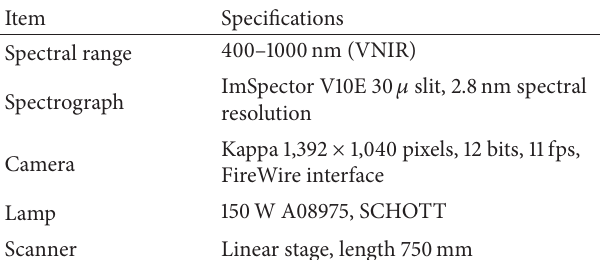
Figure 1: Overall inspection flow of the proposed system. Table 1: Specifications of the hyperspectral image acquisition